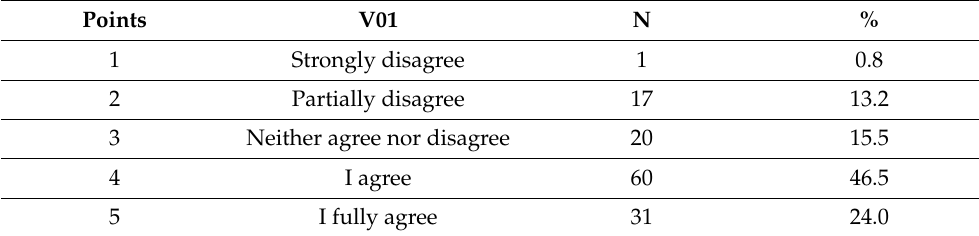
Table 9. Self-criticism regarding the game and the resources